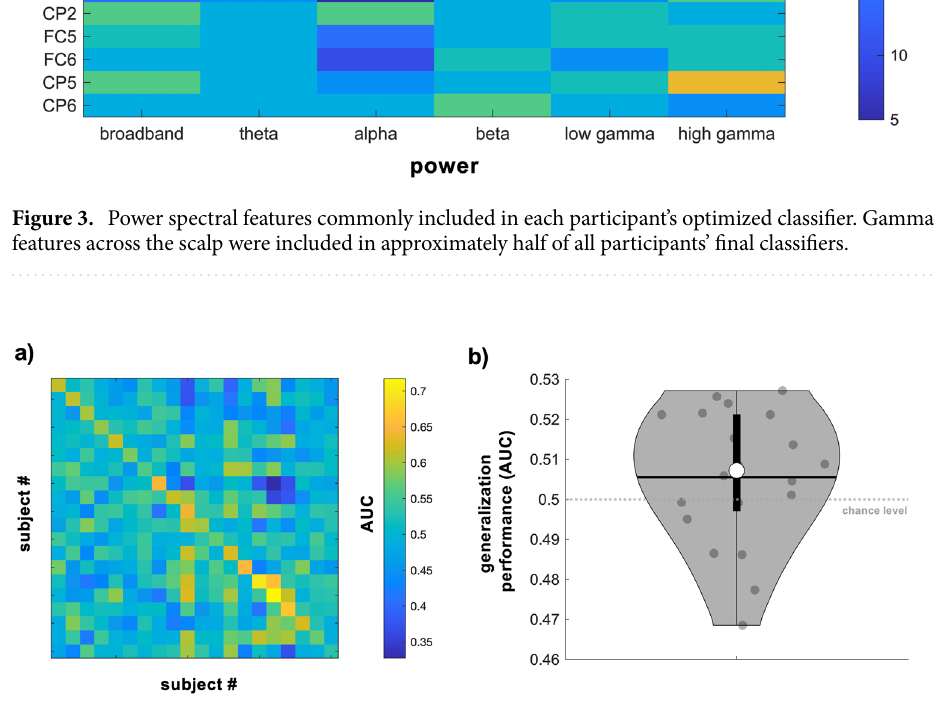
Figure 4. Cross-participant generalization of personalized classifiers. ( a ) Matrix of AUC values reflecting cross-participant generalization performance of classifiers trained using power spectral features obtained from EEG signals immediately preceding TMS (0.505–0.005 s before TMS, classifiers were trained using all trials per participant). Warmer and cooler colors indicate higher and lower AUC values, respectively. AUC values along the diagonal indicate performance of personalized classifiers and thus are identical to those shown in Fig. 2a. ( b ) AUC values indicating generalization performance averaged across all testing participants per training participant. AUC values exceeded theoretical chance in 5 of the 20 participants but not at the group level. For ( b ), grey dots = individual participant AUC values, thick whisker = interquartile range, thin whisker = full range, white dot = group median, black horizontal line = group mean, grey dashed line = theoretical chance